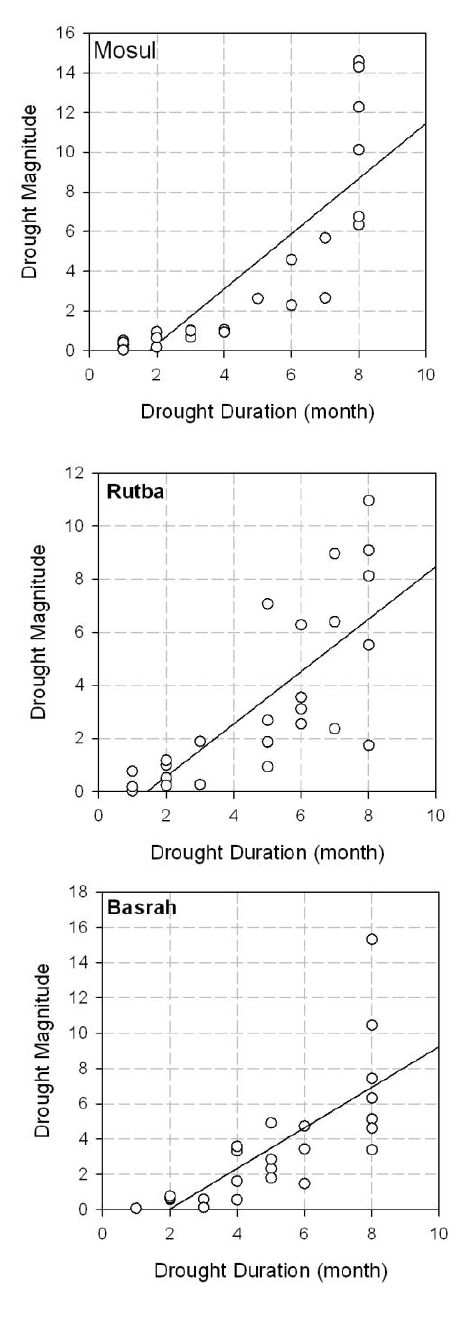
Fig. 4: Scatter diagrams of Magnitude and